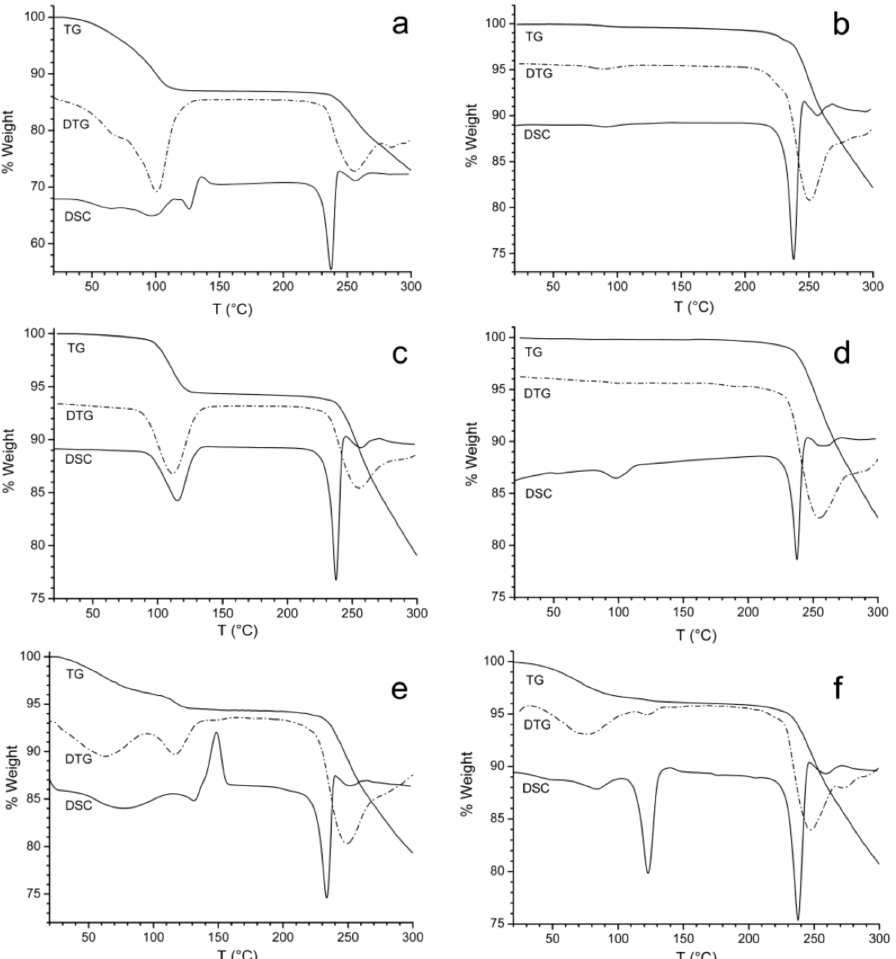
Figure 2. TG, DTG, and DSC curves of Tax-ET ( a ); Tax-EA ( b ); Tax-ACN ( c ); Tax-AET ( d ); Tax-AACN ( e ); Pristine-Tax ( f